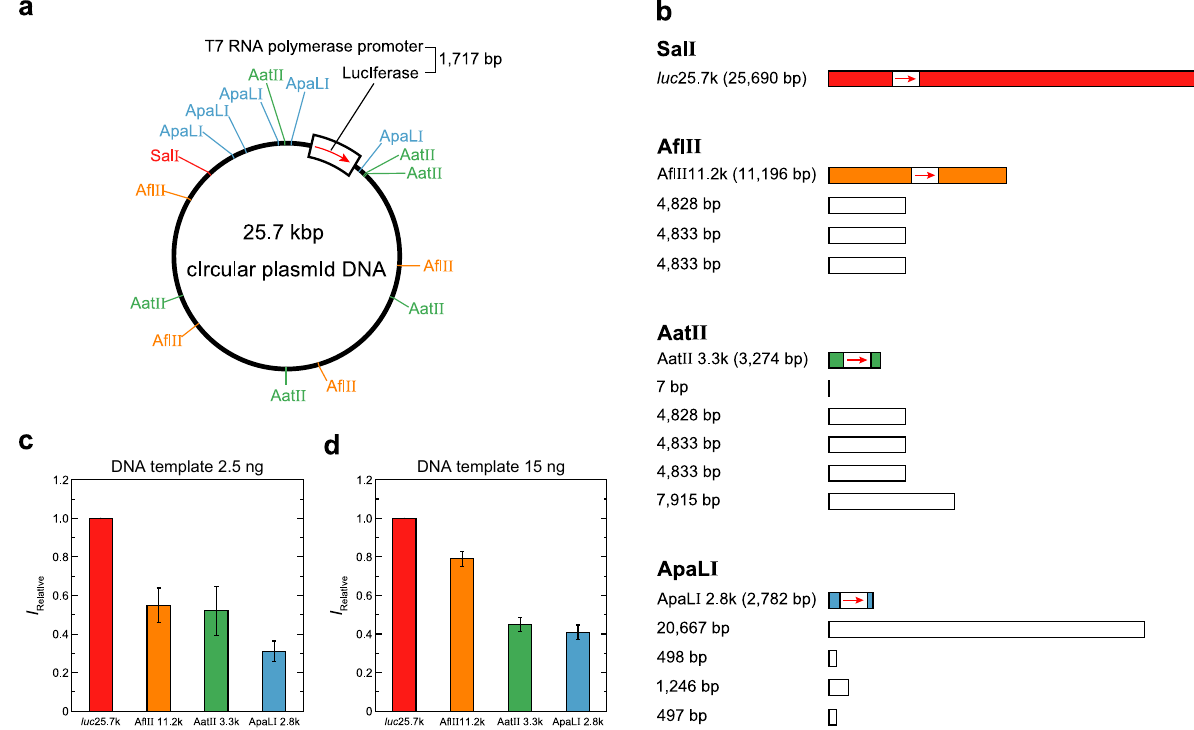
Figure 2. Nucleotide-length dependency of the coupled transcription/translation of the luc -gene. ( a ) Schematic diagram of the parental 25.7-kbp plasmid DNA with restriction enzyme digestion sites. The white box on the plasmid DNA represents a firefly luciferase reporter gene with a T7 promoter. The red arrow in the white box shows the direction of reporter gene transcription. ( b ) DNA fragments resulting from enzyme digestion reactions of the parental plasmid. Sal I yields a single 25.7-kbp linear reporter gene. Afl II, Aat II and ApaL I generate a 11.2-kbp reporter gene and three kinds of 4.8-kbp non-coding DNA fragments, a 3.3-kbp reporter gene and five kinds of non-coding DNA fragments (7-bp, three 4.8-kbp and 7.9-kbp lengths), and a 2.8-kbp reporter gene and four kinds of non-coding DNA fragments (20.7-kbp, 1.2-kbp and two 0.5-kbp lengths), respectively. The reporter genes in the DNA fragments are colored red for Sal I, orange for Afl II, green for Aat II and light blue for ApaL I treatments, respectively. ( c , d ) Efficiency, I , of the coupled transcription/translation reaction of luc -gene, as evaluated from the luminescence intensity. 2.5 ng ( c ) and 15 ng ( d ) of digested DNA mixtures were used as DNA templates for the reaction. In ( c , d ), the longitudinal axis shows the relative luminescence intensity normalized to that of luc 25.7k. The relative protein expression levels with luc 25.7k are presented as means ± SD of at least five independent